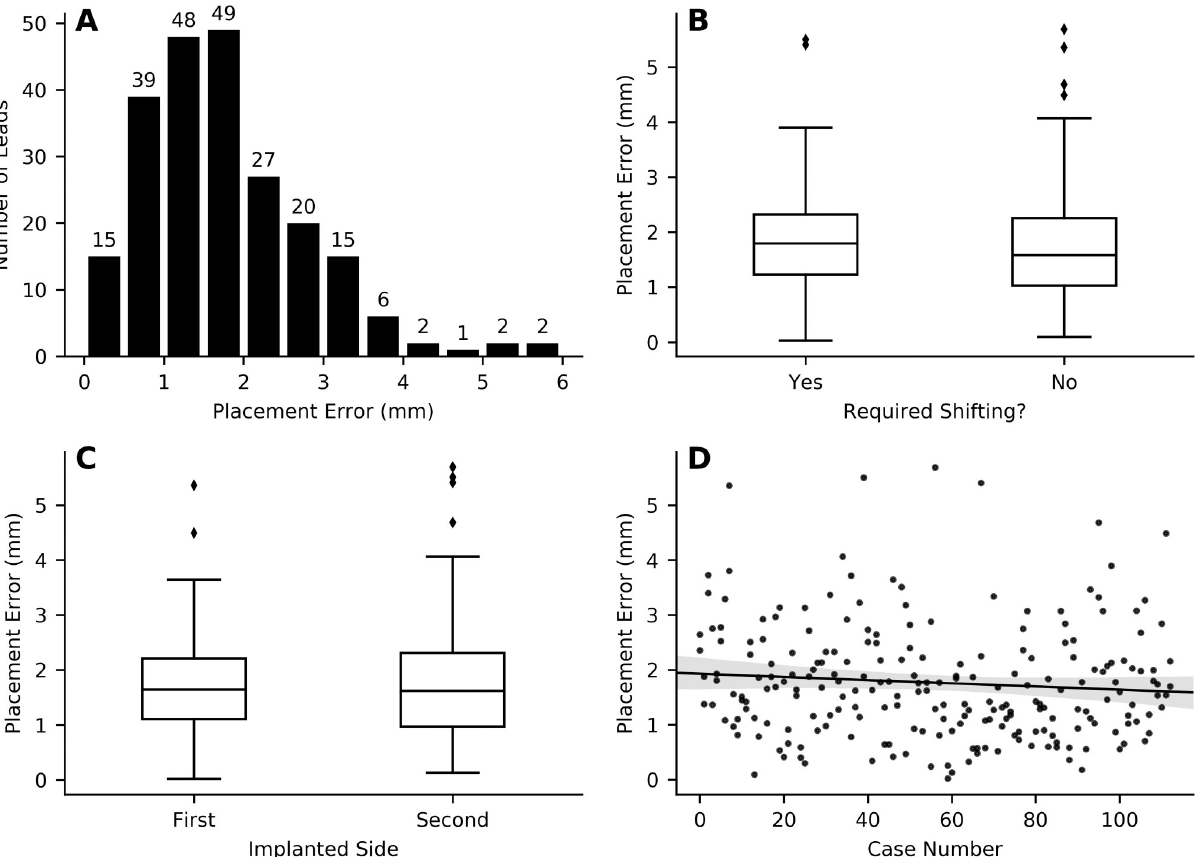
Fig 2. Results summary. The error in electrode placement between the nominated, ideal location to apply DBS in the dorsal STN versus actual electrode trajectory in 226 electrodes of 113 patients (A). An intraoperative microelectrode trajectory change was required in 48/226 (21.2%). There was no difference in electrode location error between electrodes preceded by one or more microelectrode trajectory changes versus those where no microelectrode trajectory change had occurred (Mann Whitney U-Test: U(47) = 3943, p = 0.21) (B). There was no difference in electrode location error between the first and second implanted side (Wilcoxon signed ranks: W(112) = 3106, p = 0.74) (C). There was no relationship between electrode location error and case number (linear regression: r = 0.09, p = 0.18, shaded region shows 95% confidence interval) (D).